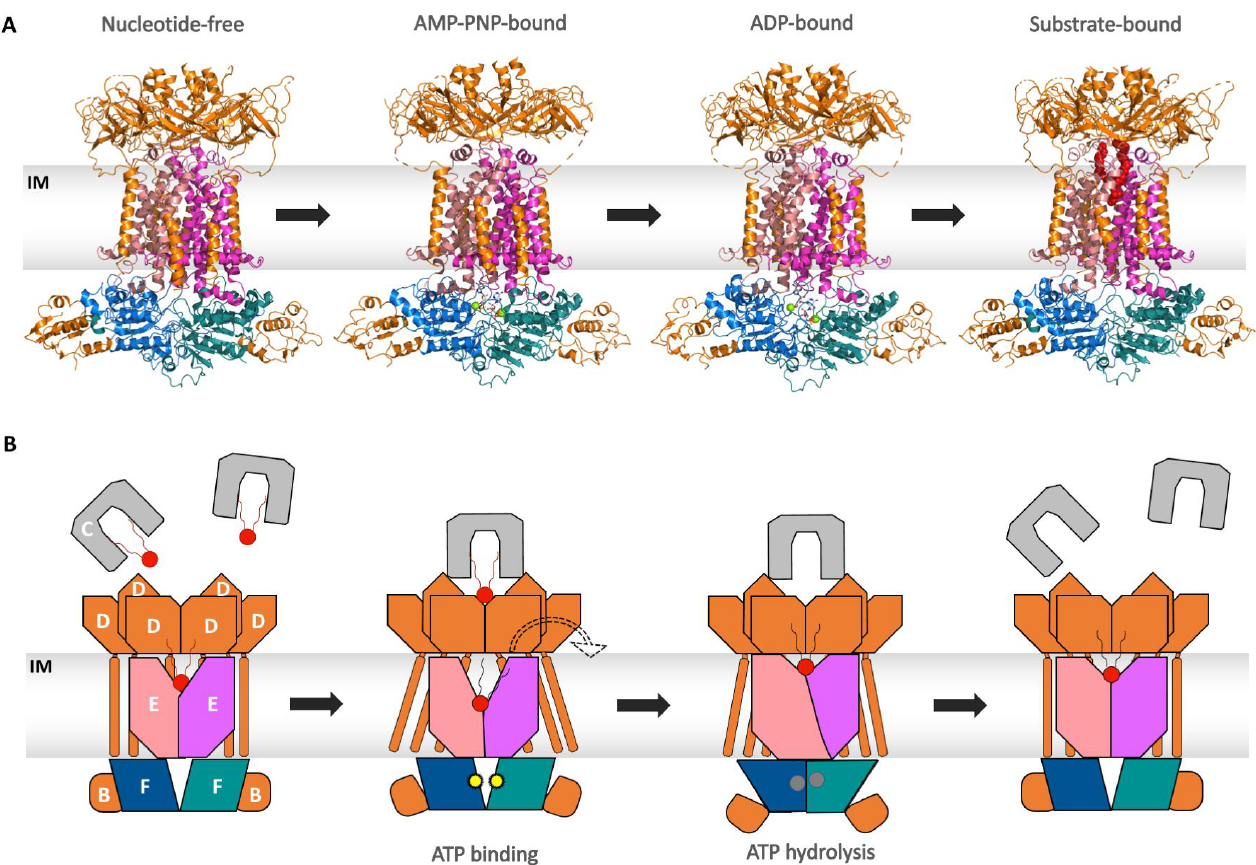
Figure 9. Structures and model representing the transport cycle of the Mla pathway. MlaC is shown in grey. The hexameric MlaD and both MlaB are shown in orange. MlaE is shown in salmon and light magenta. MlaF is shown in marine and deep teal. Lipid molecules are shown in red, and nucleotides are shown as spheres. The IM is displayed as a grey box. The peptidoglycan layer is omitted for reasons of clarity. ( A ) : Different states of the ABC transporter during the transport cycle: nucleotide-free (PDB: 6ZY2), AMP-PNP-bound (PDB: 6ZY9), ADP-bound(PDB: 6ZY4), and substrate-bound (PDB: 6ZY3). ( B ) : A schematic model of the retrograde transport of the lipid via MlaFEDB. Lipid-loaded MlaC binds to MlaD in the resting state of MlaFEDB. Binding of ATP (yellow dots) prompts the exit of the lipid molecule present in the cavity of MlaE from the last transport cycle. ATP hydrolysis to ADP (grey circles) and P i prompts dimerization of MlaF and conformational changes in MlaE, which ultimately lead to the extraction of lipid from MlaD-MlaC into the cavity of MlaE. Upon release of hydrolyzed products, the conformation gets back to the resting state.